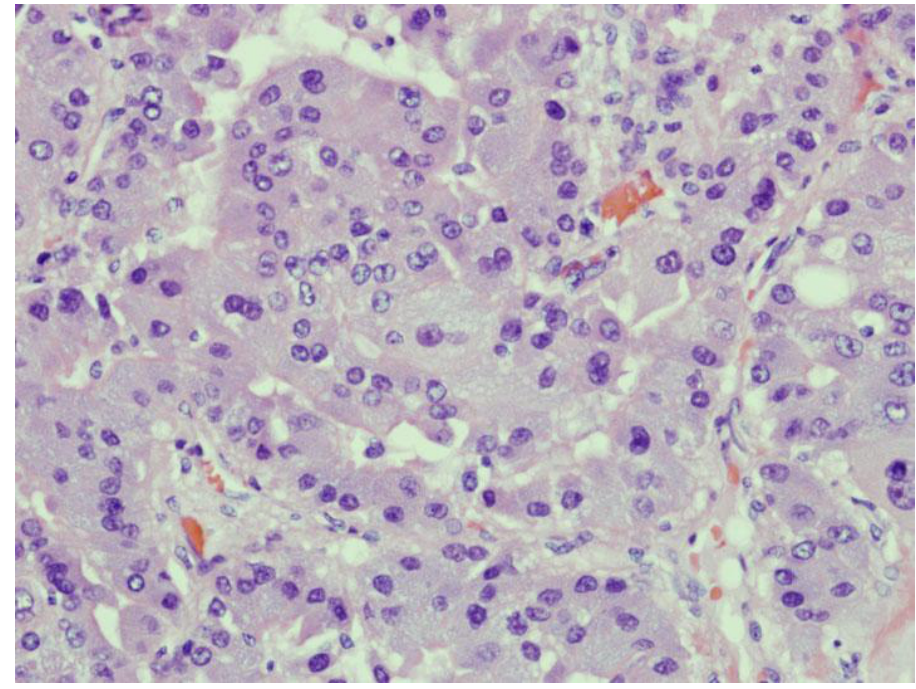
FIGURE 5. Tumor cells have abundant granular cytoplasm, round nuclei, and prominent nucleoli, features characteristic of